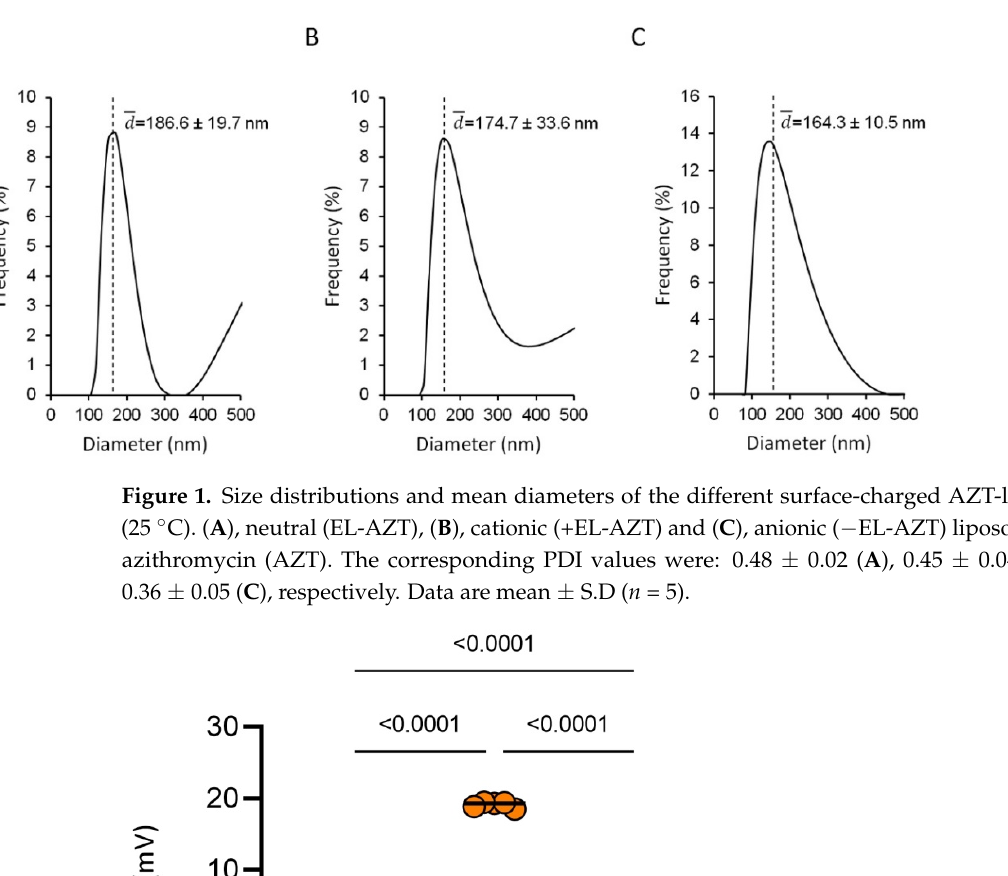
Figure 1. Size distributions and mean diameters of the different surface-charged AZT-liposomes (25 °C). ( A ), neutral (EL-AZT), ( B ), cationic (+EL-AZT) and ( C ), anionic ( − EL-AZT) liposomes with azithromycin (AZT). The corresponding PDI values were: 0.48 ± 0.02 ( A ), 0.45 ± 0.04 ( B ) and 0.36 ± 0.05 ( C ), respectively. Data are mean ± S.D ( n = 5).